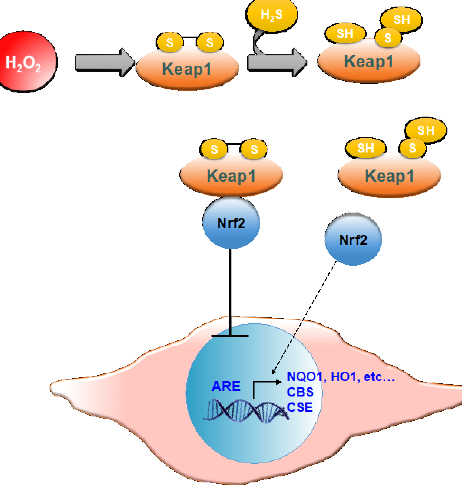
Figure 10. Schematic representation of Nrf-2 activation of ARE by H 2 S. Keap 1, Kelch-like ECH-associated protein 1; Nrf2, nuclear erythroid factor 2-related factor 2; ARE, antioxidant response elements; NQO1, NAD(P)H quinone oxidoreductase 1; HO1, heme oxygenase 1; CBS, cystathionine β -synthase; CSE, cystathionine γ